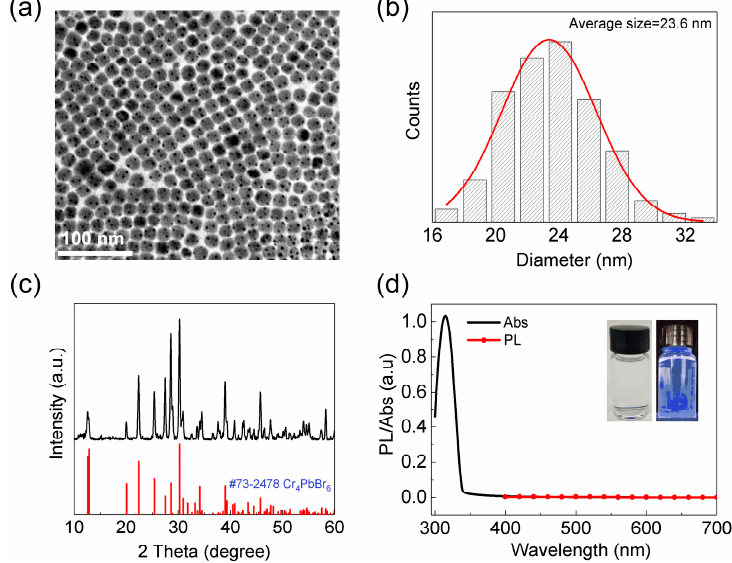
Figure 1. Characterization of Cs 4 PbBr 6 nanocrystals (NCs): ( a ) TEM image, ( b ) particle size distribution, ( c ) X-ray diffractometer (XRD) pattern, and ( d ) UV-vis absorption and photoluminescence (PL) spectra. Insets are the photographs of Cs 4 PbBr 6 NCs under sunlight and UV light